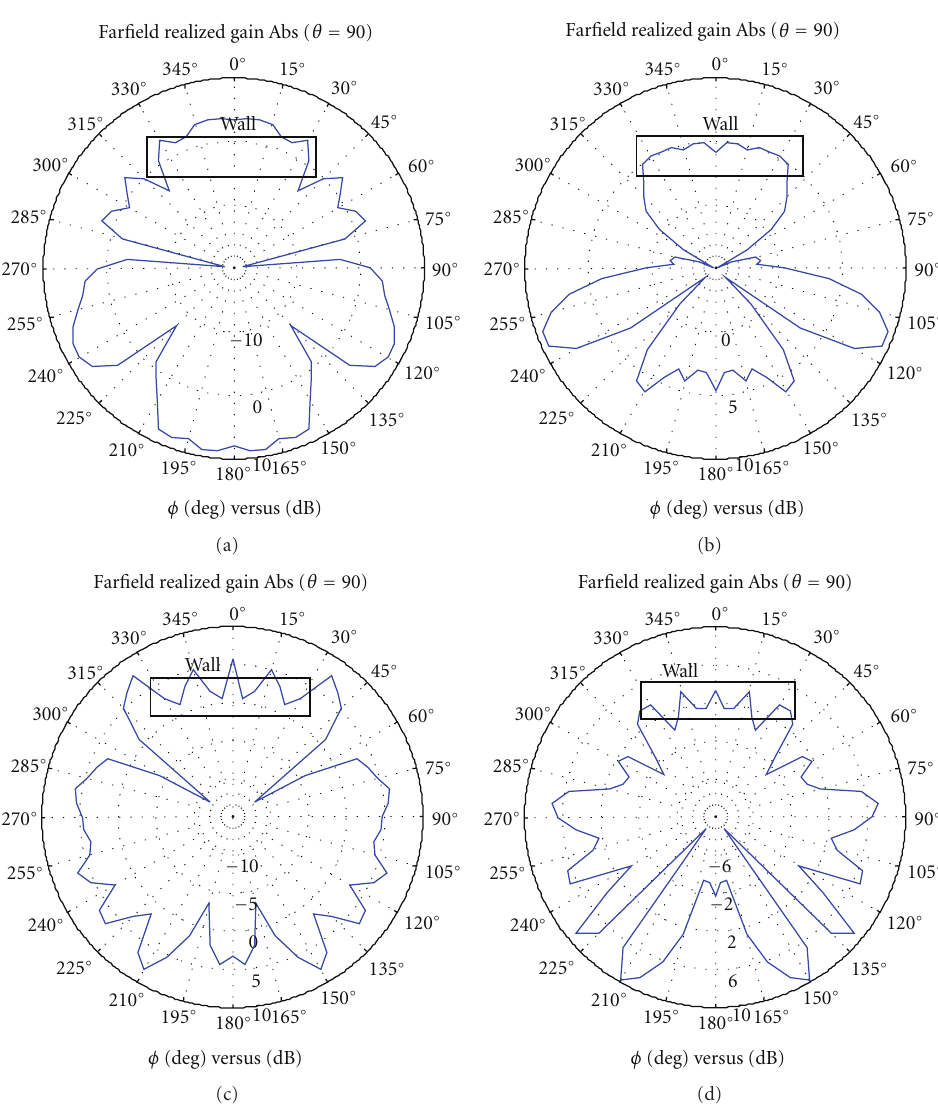
Figure 15: Examples of power gains in the azimuth plane for four realizations.